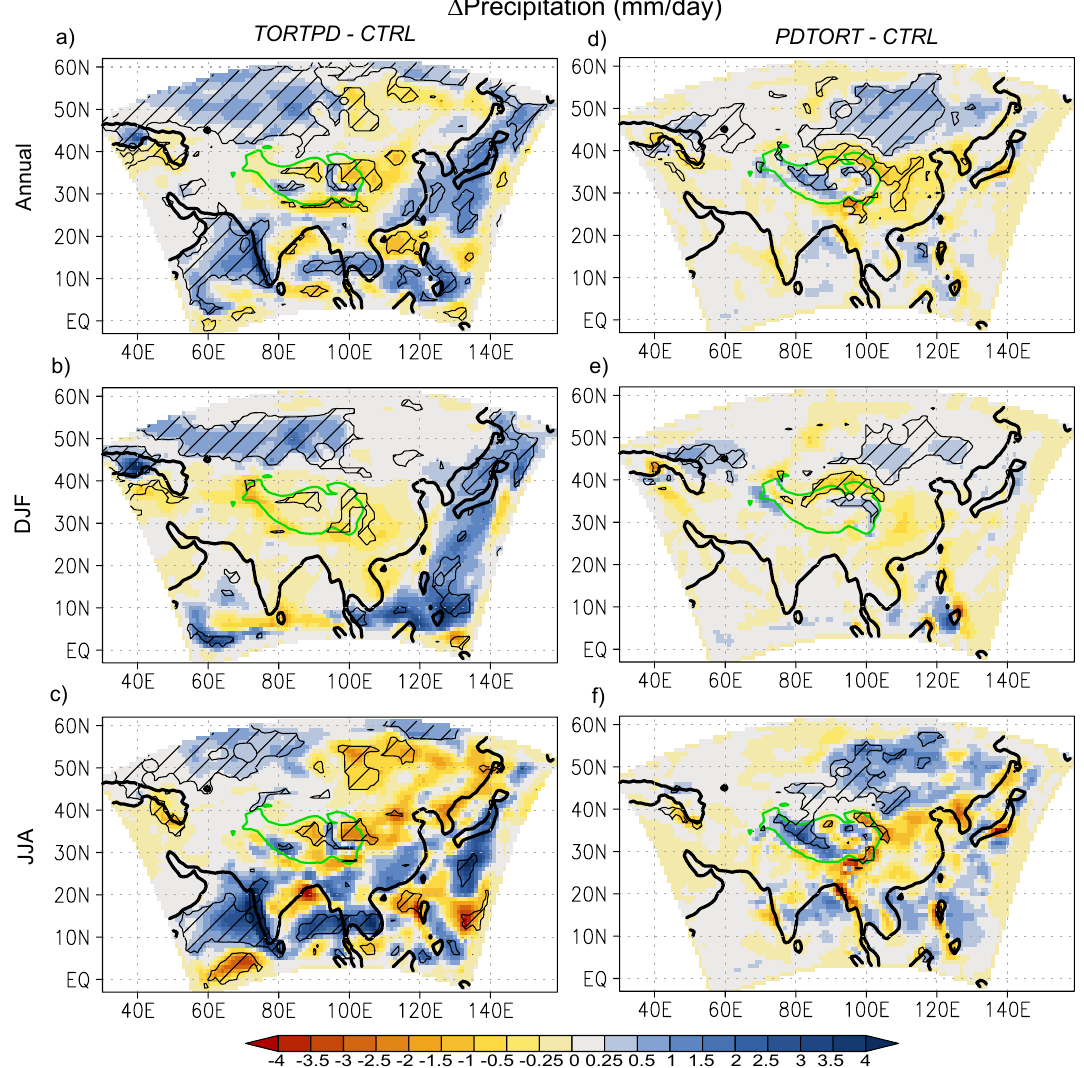
Fig. 12. Precipitation (mmday − 1 ) anomalies of TORTPD and PDTORT to the present-day control run (CTRL). (a, b, c) TORTPD minus CTRL, (d, e, f) PDTORT minus CTRL. (a, d) Annual, (b, e) winter (DJF), (c, f) summer (JJA). The hatched areas show the significant anomalies with a Student’s t-test ( p = 0 . 05). The green contour denotes the extent of the present-day Tibetan Plateau ( >